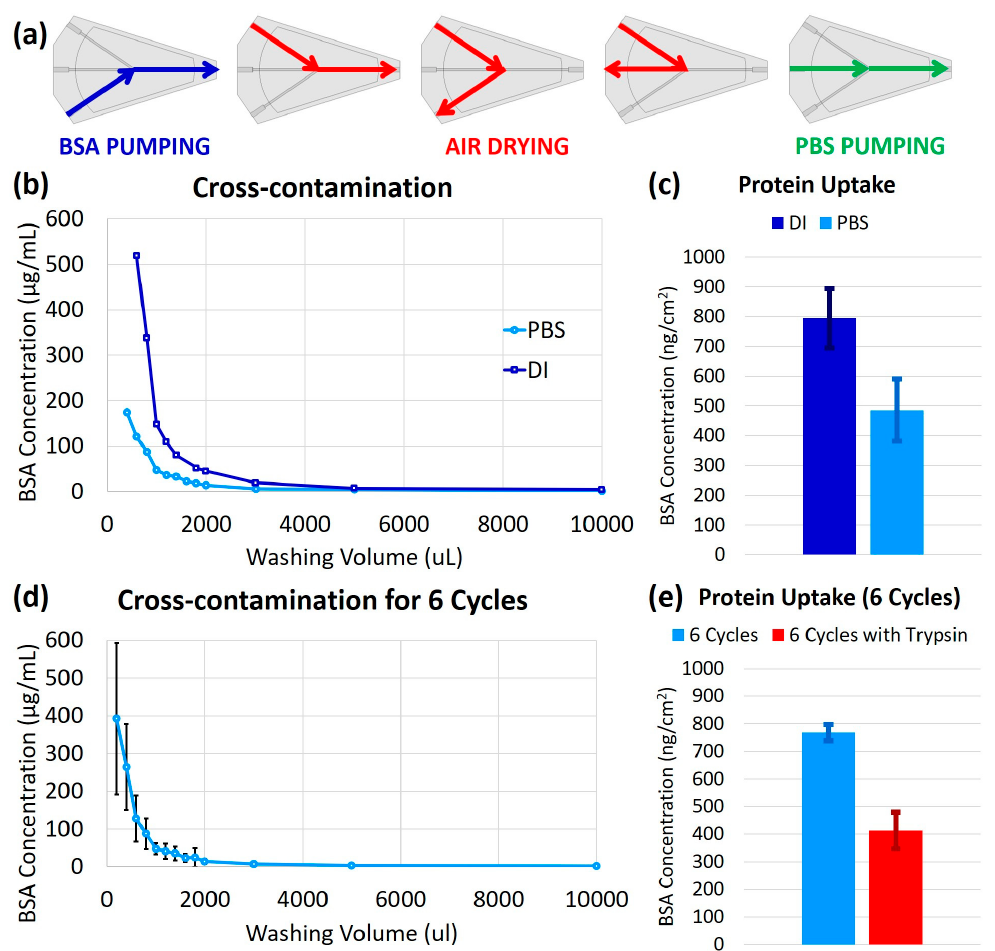
Figure 3. Protein cleaning characterization: ( a ) Graphical representation of one-cycle of the cleaning procedure. The PBS from the outlet was collected at set intervals for the cross-contamination results; ( b ) Cross-contamination of a single-use chip using deionized (DI) water compared to PBS as a cleaning solution with the BSA concentration in the output PBS or DI sample using a new chip. Cross-contamination is significantly reduced by using PBS, as compared to DI; ( c ) Protein absorption by a single-use 3D-printed chip after cleaning with DI compared to PBS. After cleaning with PBS, approximately half as much protein uptake remained, as compared to after cleaning with DI; ( d ) Cross-contamination of a repeated-use chip with the BSA concentration in the output PBS sample for 6 cycles using the same chip repeatedly, graphed as the mean with standard deviation error bars; ( e ) Protein absorption by the 3D-printed chip after 6 cycles of repeated use. By adding a post-cleaning treatment of trypsin after the 6 cycles of repeated use, the protein uptake is decreased by nearly half. The protein uptake after six repeated cycles was shown to be (758 ± 30) ng/cm 2 (Figure 3e), which is approximately twice the amount of uptake after single use of the chip. This showed